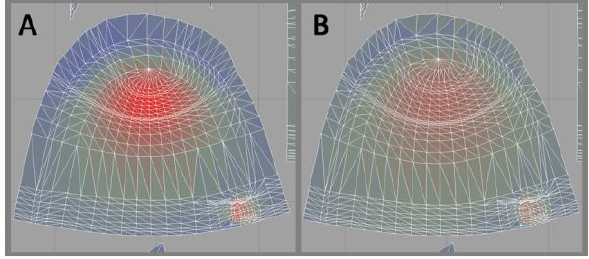
Figure 6. A) Automatic parameterization, B) the same island after the application of a relax tool inside an